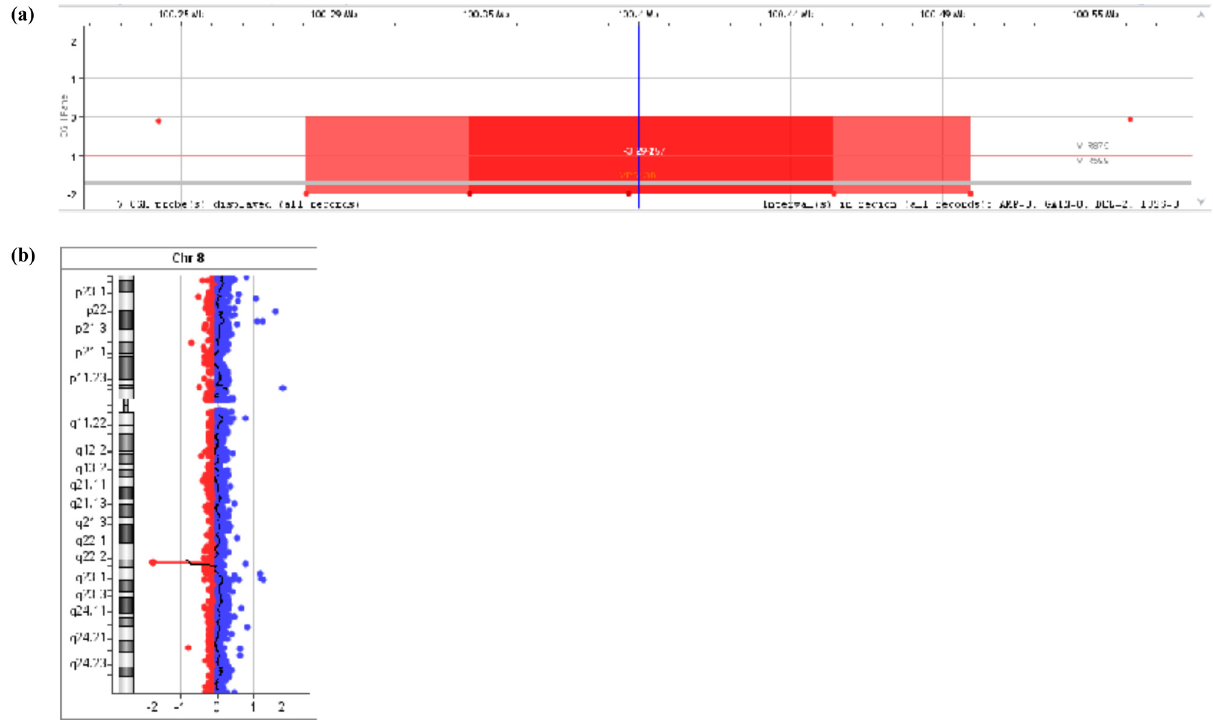
Figure 1: ( a ) and ( b ) Results of a CGH analysis pointing a partial loss of both copies of genetic material at the VPS13B gene: 8q22.2 ( 100290888_100508951 ) x0 ( Agilent Technologies SurePrint G3 ISCA V2 CGH 8x60K [ hg19 ])